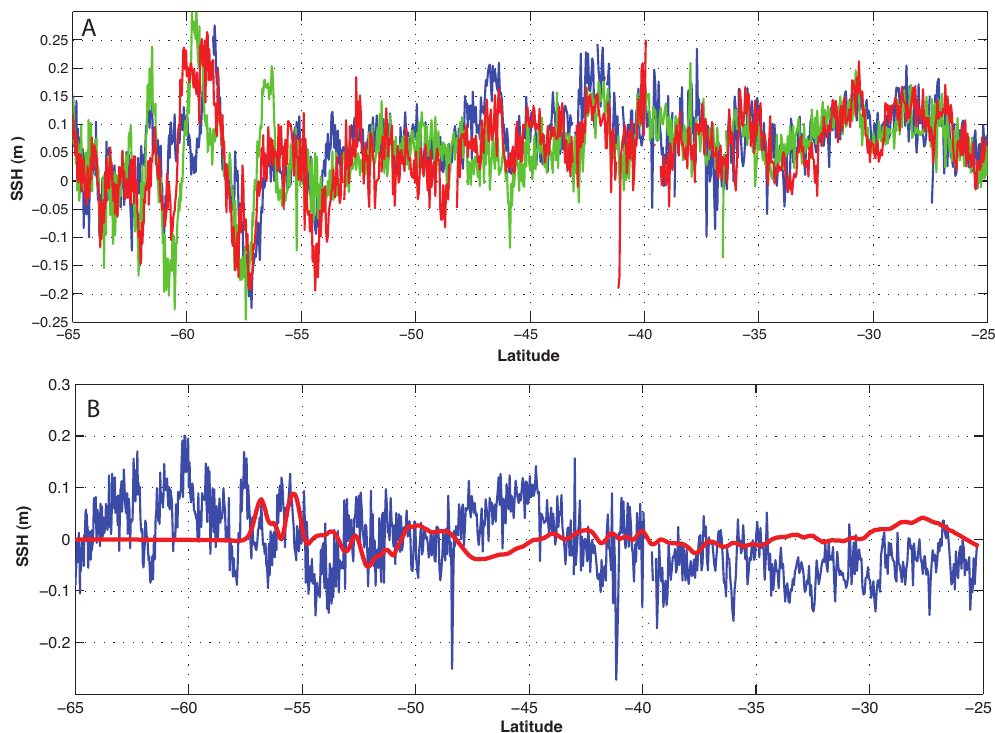
Fig. 6. (A) SSH data for pass 13 of Jason-2 cycles 60 (blue), 61 (red – tsunami) and 62 (green). (B) Filtered SSH data (blue) for pass 13 of cycle 61 with MOST model results (red)